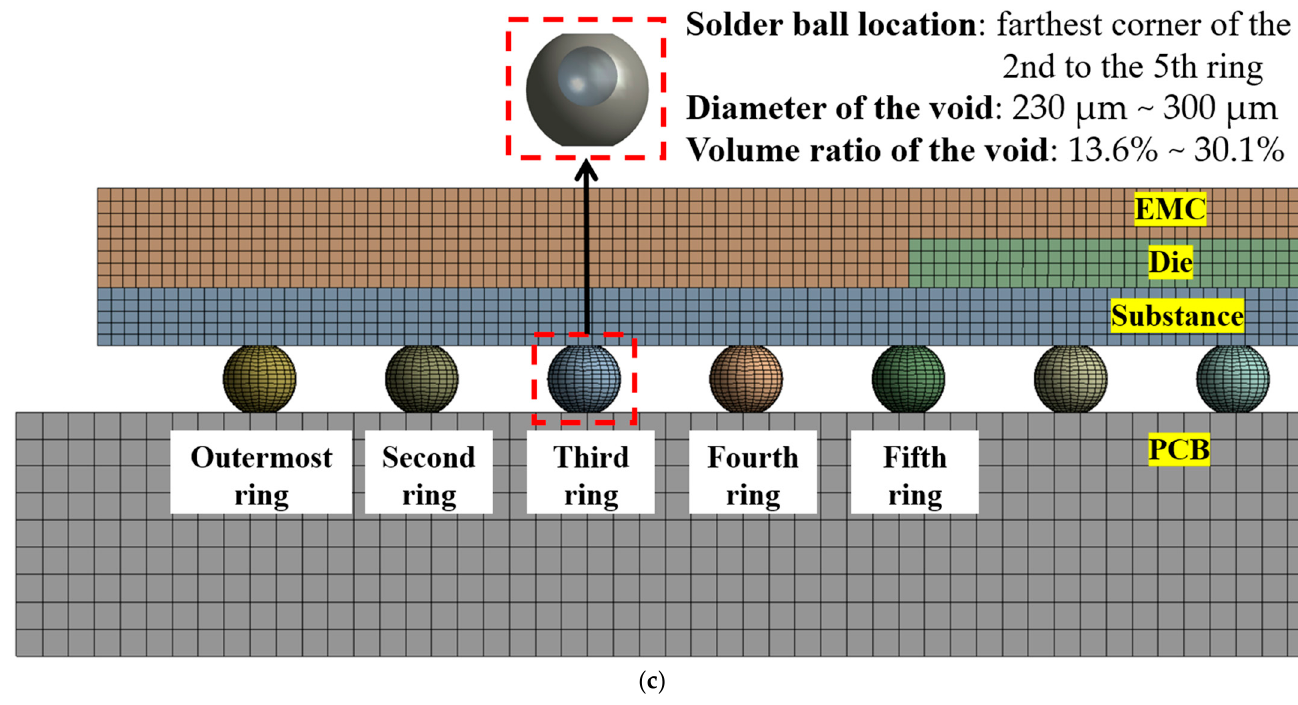
Figure 2. ( a ) Locations of critical solder balls. ( b ) Solder ball array of 1/4 BGA model. ( c ) Macro void in solder ball of 1/4 BGA model. Table 1. Dimensions of each component in the BGA package.